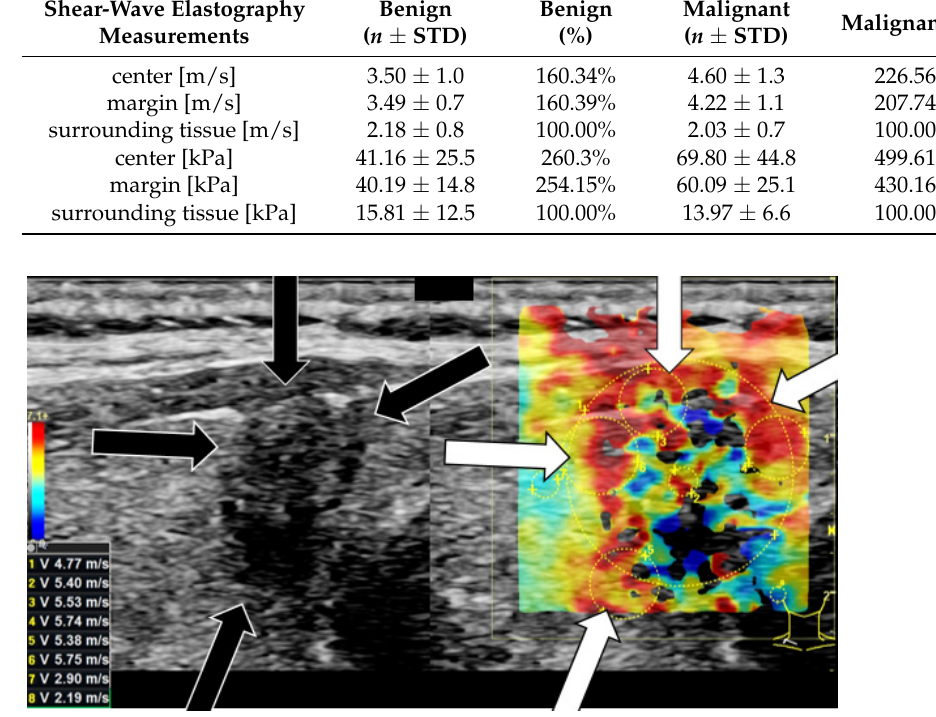
Figure 2. Shear-wave elastography [m/s] examination on a right thyroid lobe with thyroid carcinoma. The arrows (black arrow in B-mode; white arrow in shear-wave elastography) point at irregular hard areas. The stiffness values of the lesion all surpass the calculated cut-off value of 4.04 marginally and 3.88 centrally. The stiffness values of the normal thyroid tissue are lower.